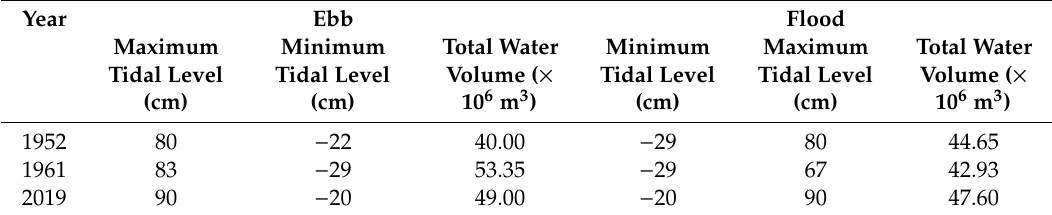
Table4. TotalwatervolumesexchangedthroughthesectiondepictedinFigure15a, duringasemidiurnal tide, having the specified maximum and minimum level, computed by Dorigo [51] in 1952 and 1961 and that derived from the present simulations during the Sirocco event with a wind speed of 12 m / s.